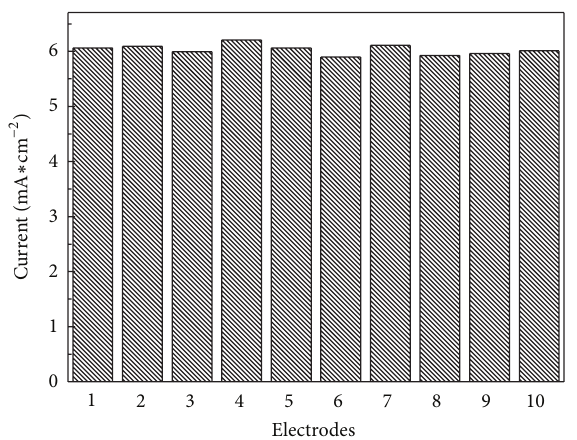
Figure 8: Current response of 10 different Ag-TiO 2 (500 ∘ C) nan- otube electrodes to 1.0mM glucose in PBS (7.0).